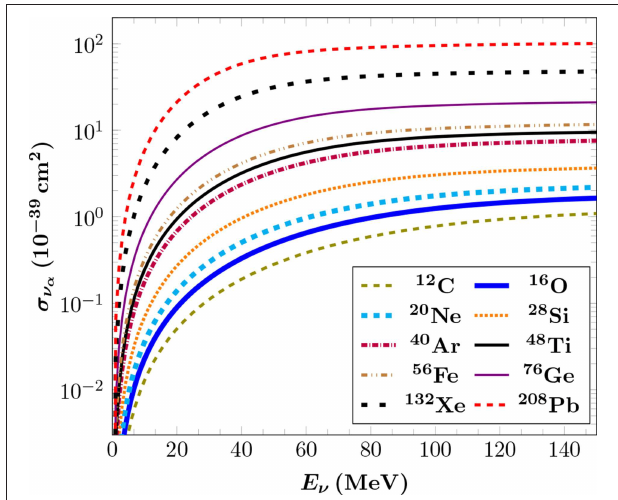
( E ν ) for a set of nuclear α ( ¯ ν α )